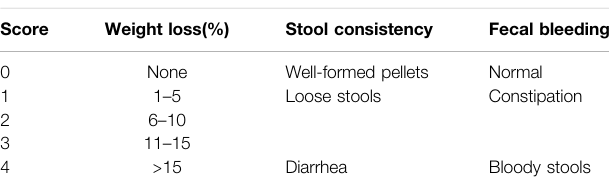
TABLE 1 | Disease activity index(DAI) score.